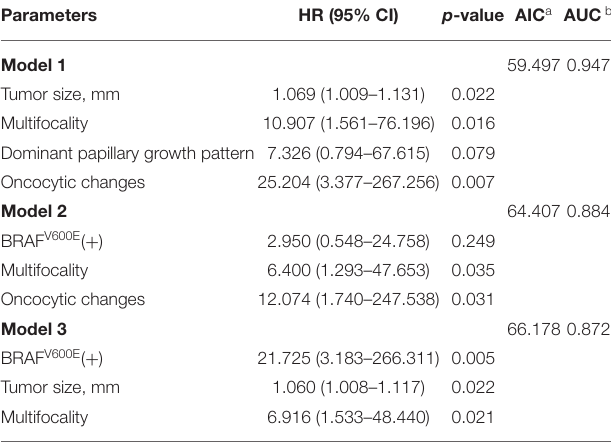
TABLE 2 | Multivariate proportional hazard models of RAI-R